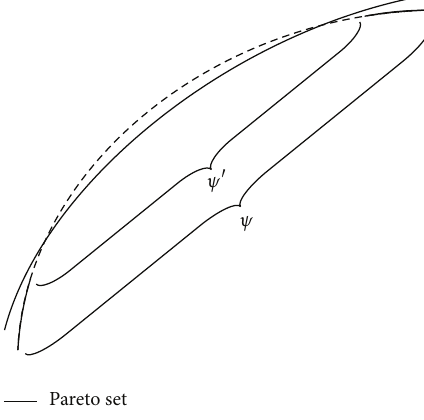
Figure 5: Illustration of